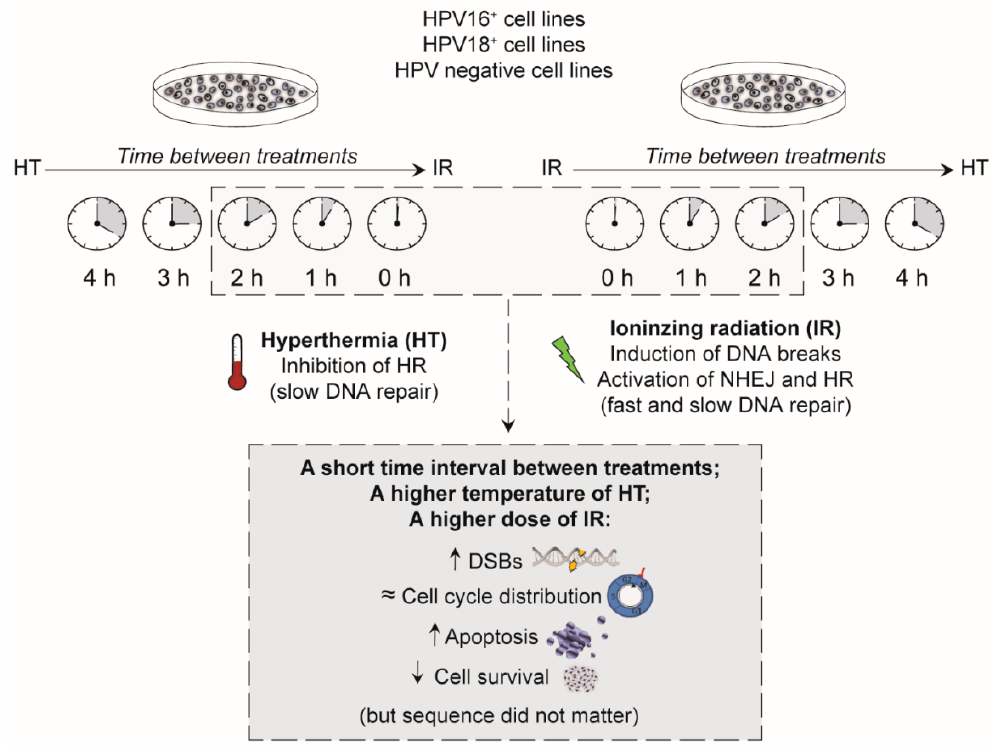
Figure 5. Summary. Effects of temperature, sequence, and time interval. A shorter time interval between ionizing radiation (IR) and hyperthermia (HT), a higher temperature of hyperthermia, and a higher dose of ionizing radiation were found to be of great importance in cell survival, by causing more residual DNA double strand breaks (DSBs) and higher levels of apoptosis. Either hyperthermia prior to ionizing radiation or hyperthermia after ionizing radiation did not matter on the number of DNA breaks, on the cell cycle distribution, levels of apoptosis, or on cell survival.